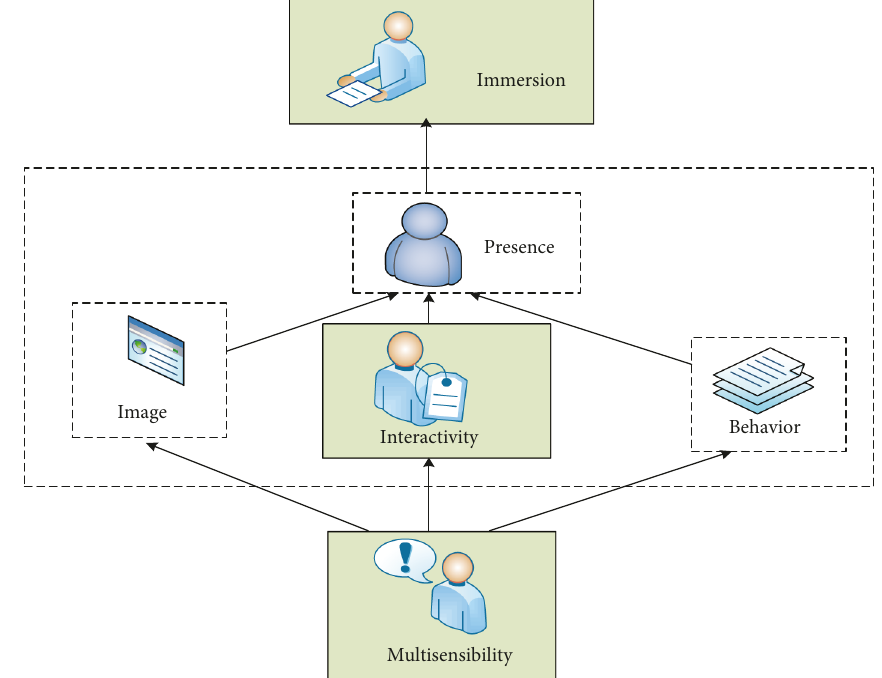
Figure 3: The main technology of virtual